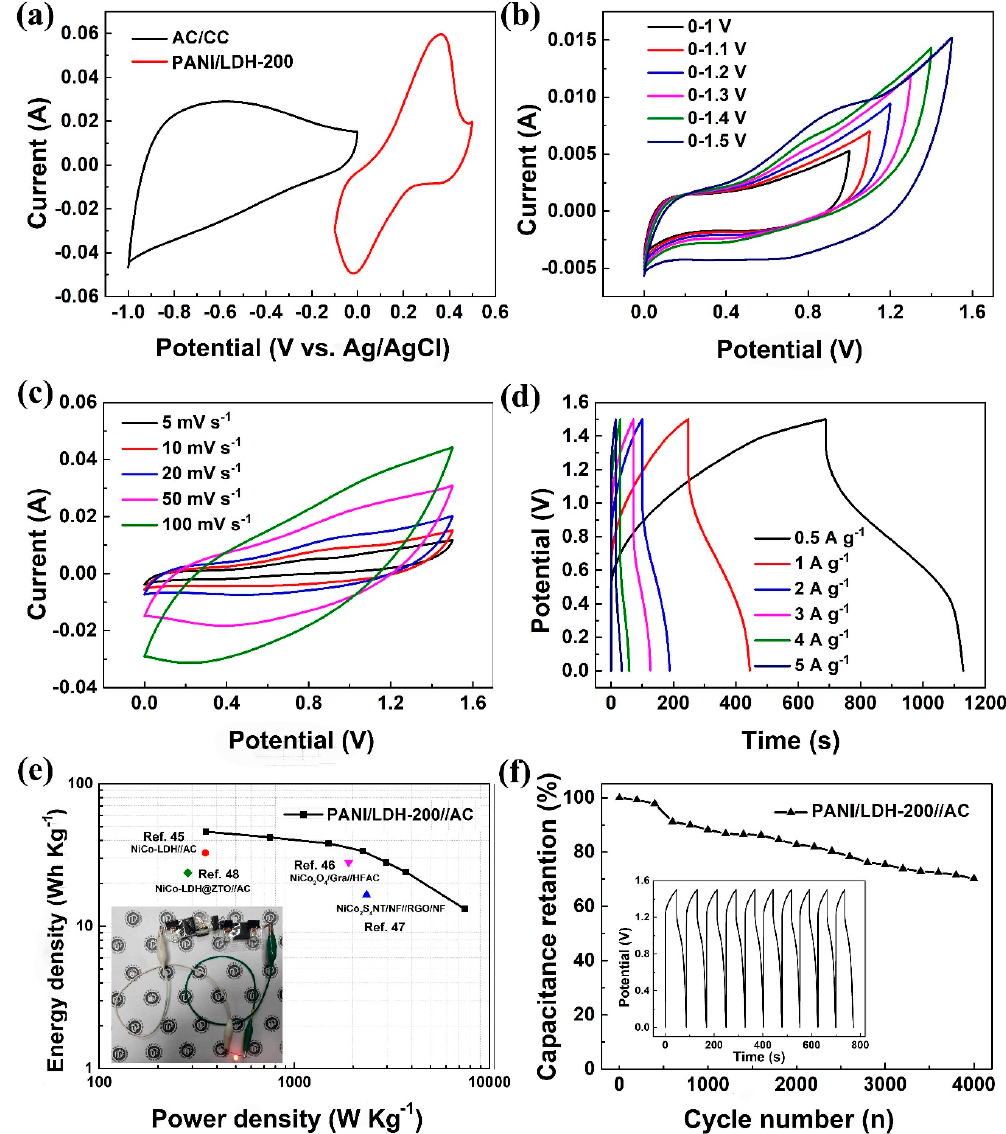
Figure 7. ( a ) CV curves of AC and PANI/LDH-200 at a scan rate of 20 mV s − 1 ; ( b ) CV curves at a scan rate of 20 mV s − 1 within different potential windows; ( c ) CV curves of the PANI/LDH-200//AC at various scan rates in a potential window of 0 to 1.5 V; ( d ) GCD curves of the PANI/LDH-200//AC at different current densities; ( e ) Ragone plot of the ASC, inset shows a photo of the ASC device; ( f ) cycling stability of the ASC at a scan rate of 4.0 A g − 1 , and the inset shows the GCD curves of the last 10 cycles.